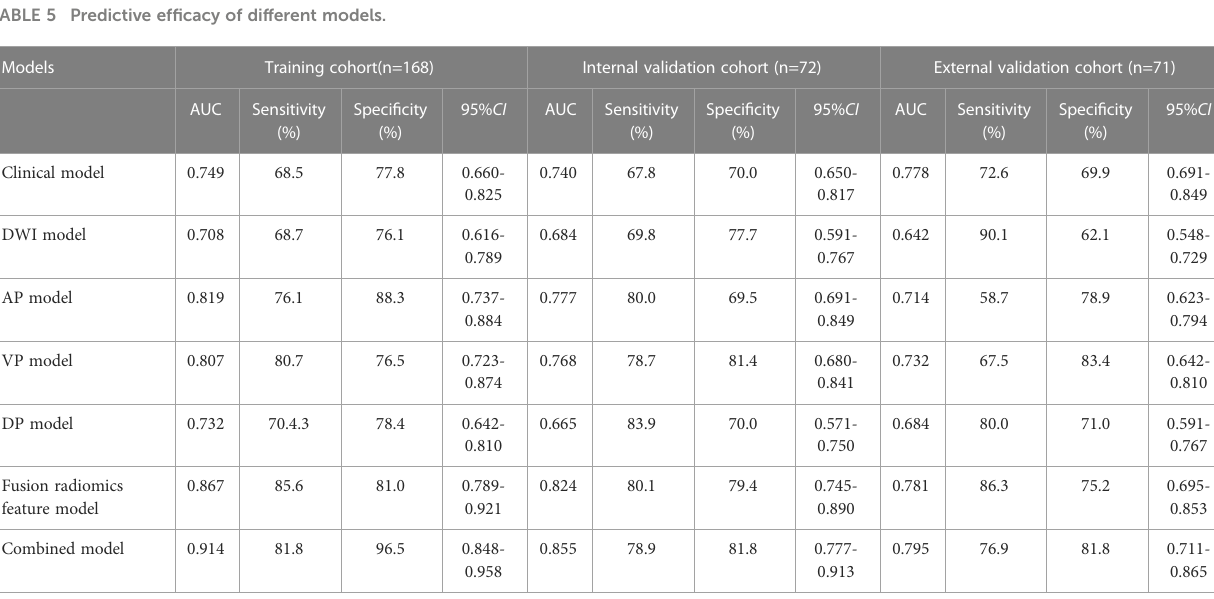
TABLE 5 Predictive ef fi cacy of different